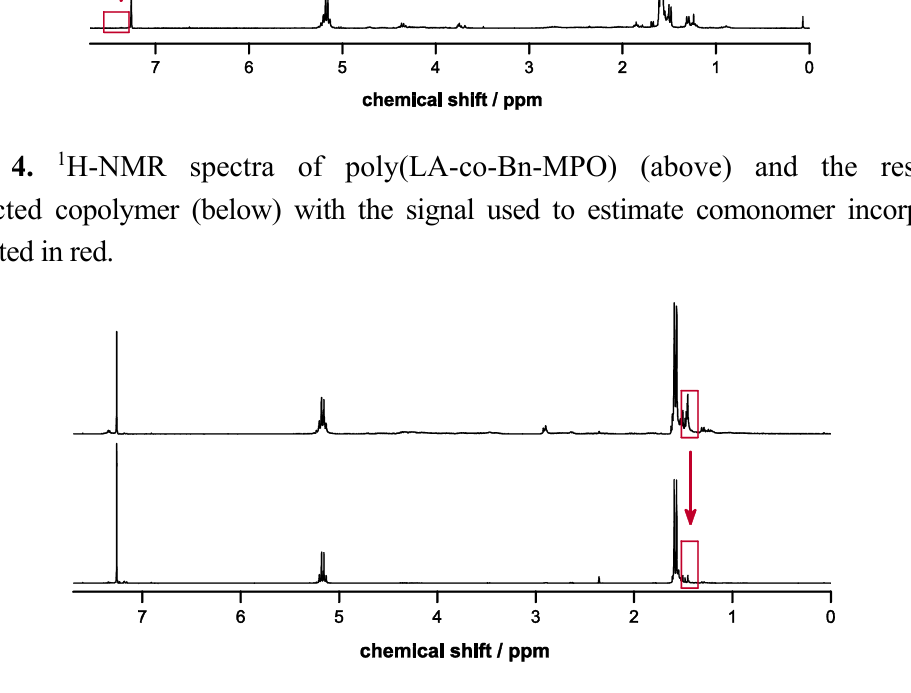
Figure 5. 1 H-NMR spectra of poly(LA-co-BocN-MPO) (above) and the respective deprotected copolymer (below) with the signal used to estimate comonomer incorporation highlighted in